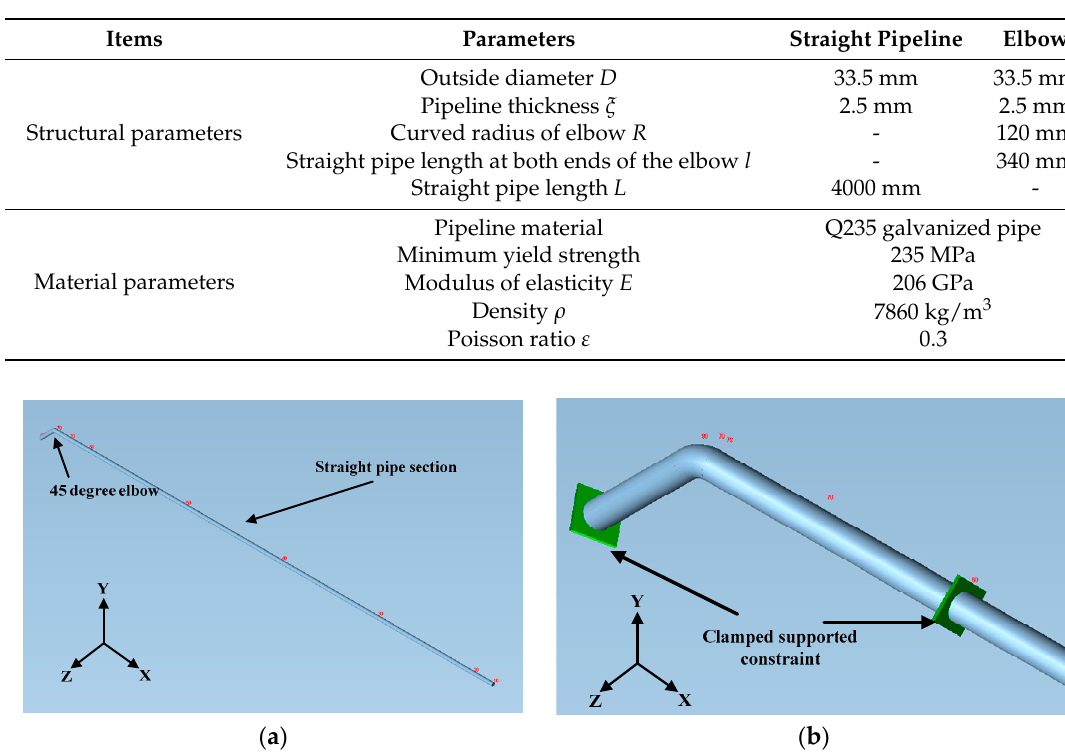
Figure 3. Schematic diagram of a simple pipe model. Table 1. Pipeline material parameters and structural parameters.